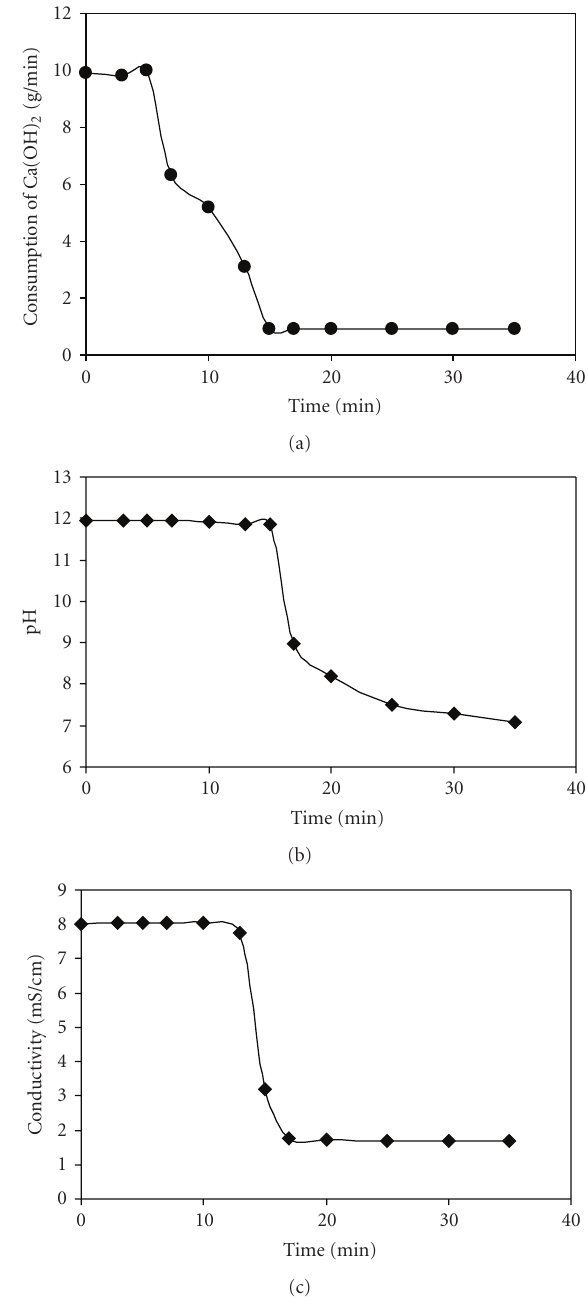
Figure 2: (a) Consumption of Ca(OH) 2 during the carbonation process without orifice (4% Ca(OH) 2 and 5l/min CO 2 flow rate). (b) Change in pH during the carbonation process without orifice (4% Ca(OH) 2 and 5 l/min CO 2 flow rate). (c) Change in conductivity during the carbonation process without orifice (4% Ca(OH) 2 and 5l/min CO 2 flow